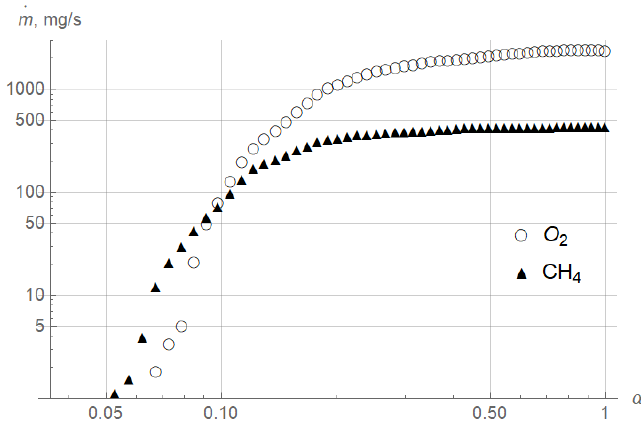
Figure 4. Mass flow rate measurements in terms of the valve opening level.